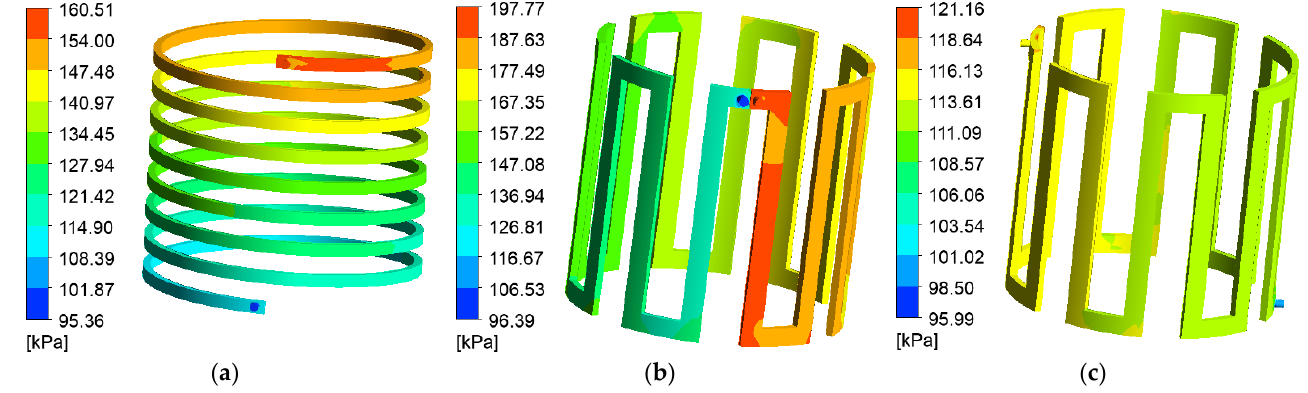
Figure 14. Pressure distribution of the three cooling channel structures. ( a ) Spiral structure; ( b ) axial structure 1; ( c ) axial structure 2.